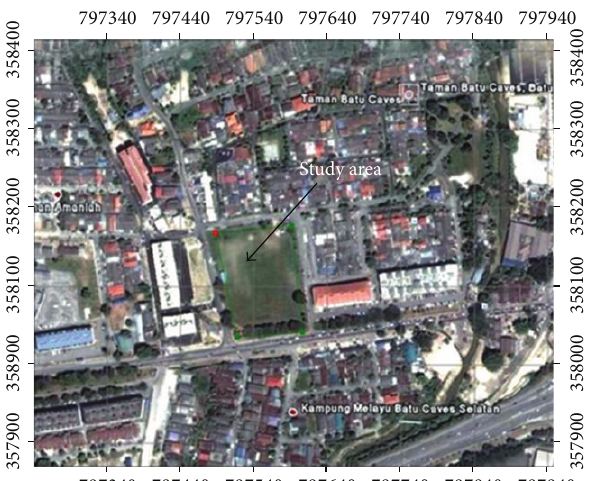
Figure 2: Study area of Batu Cave (Google Map, 2011).